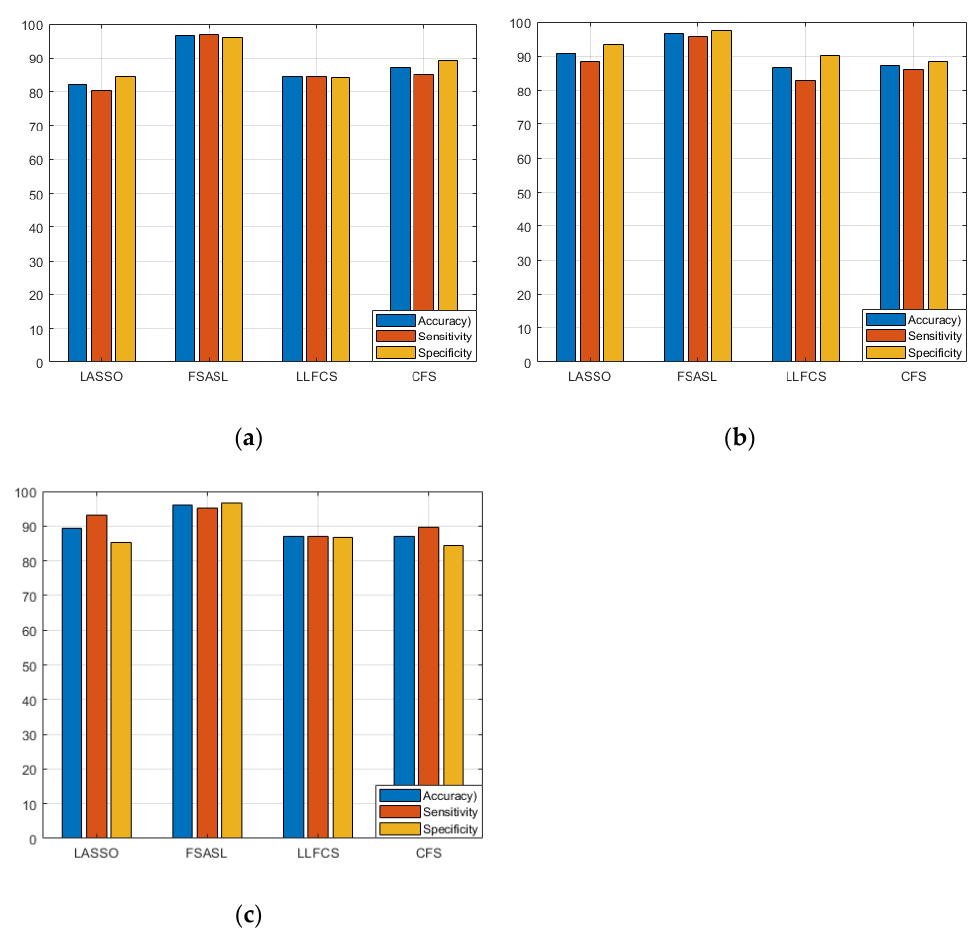
Figure 7. Classification performance using ML-RELM classifier on whole brain network using different feature selection methods. ( a ) AD against HC; ( b ) HC against MCI; ( c ) MCI against AD.